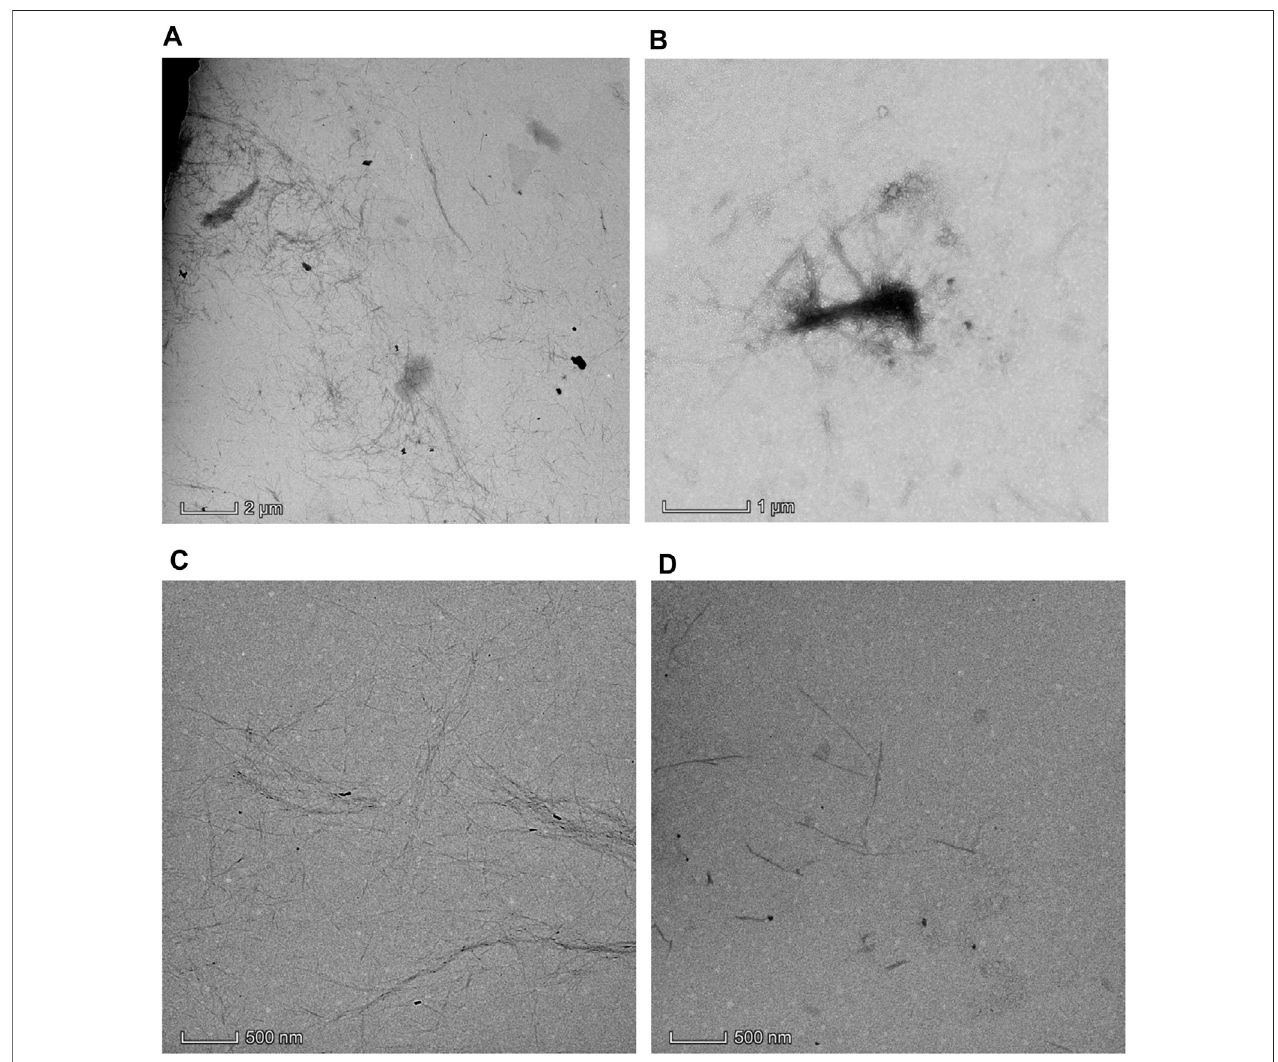
FIGURE4| TEMimagesoftheCNCunderdifferentsulfuricacidconcentrations: (A) RT,40%wt,and120 min; (B) RT,40%wt,and 120 min; (C) RT,55%wt,and 120 min; (D) RT, 65% wt, and 120 min.